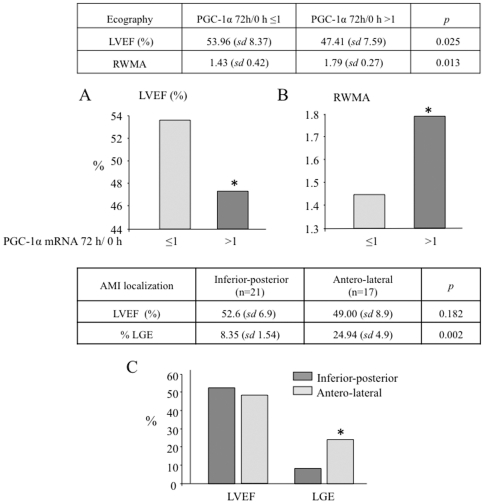
PGC-1α induction positively correlates with cardiac ventricular dysfunction.
A) LVEF and B) RWMA, were determined by ecocardiography. The estimated mean for patients that induced PGC-1α levels (PGC-1α 72 h/0 h ≥1) is compared to that of patients that did not induce PGC-1α (PGC-1α 72 h/0 h ≤1) after STEMI. C) Antero-lateral infarcts are associated to larger necrotic areas than inferior-posterior infarcts as determine by LGE on CRM. The graph shows mean LVEF and necrotic area (LGE) of patients with antero-lateral or inferior-posterior infarcts. Data are means +/−SD. (*) p<0.05.